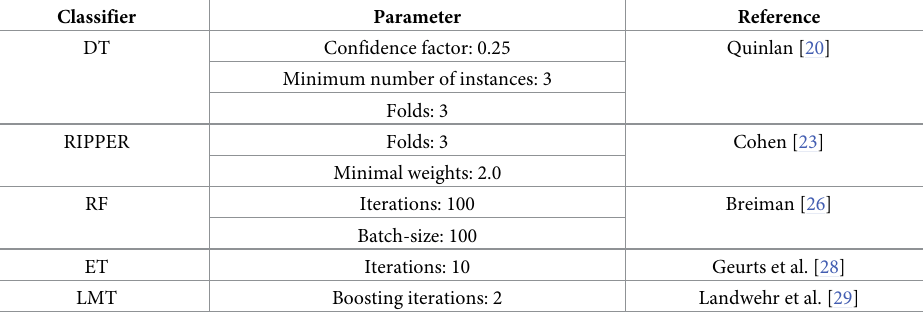
Table 4. Parameter settings of the five RBML